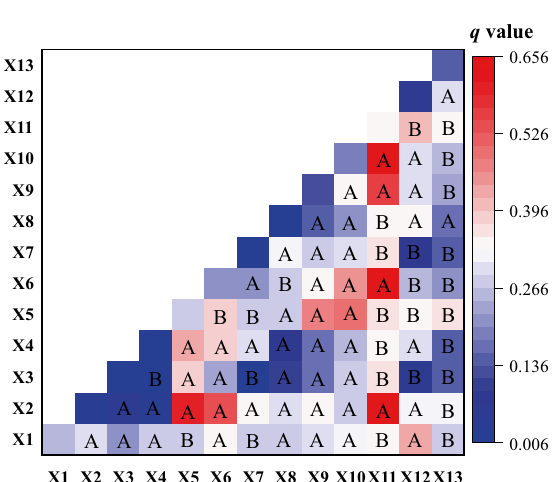
Figure 10. Detection results of indicator interaction: ( A ) refers to nonlinear enhancement; ( B ) refers to the linear